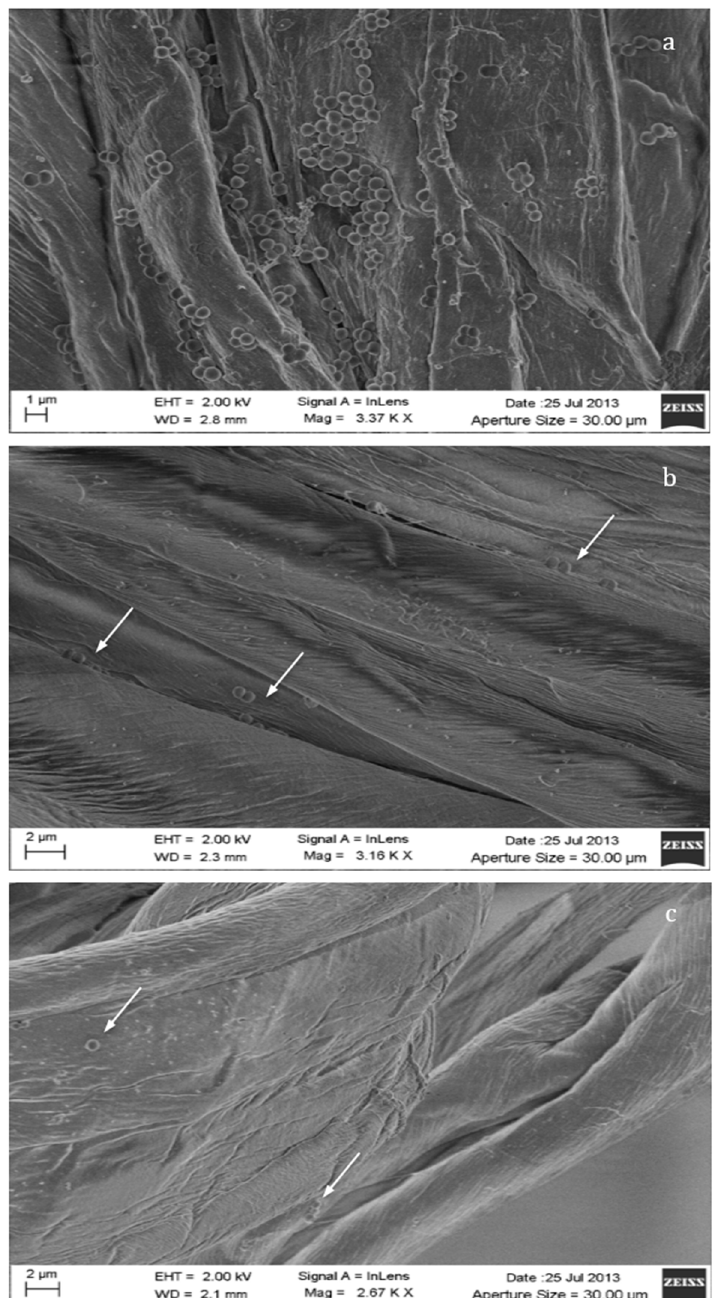
Figure 6. SEM analysis on bacterial cells adhered and proliferated on the cotton gauzes: ( a ) untreated gauze; ( b ) gauze treated with 0.5 wt/v % silver; ( c ) gauze treated with 4 wt/v % silver.